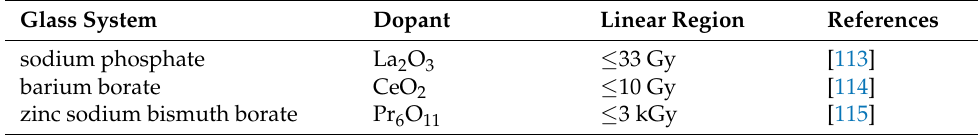
Table 1. Linear regions of thermoluminescence dose response for various glass systems. Glass